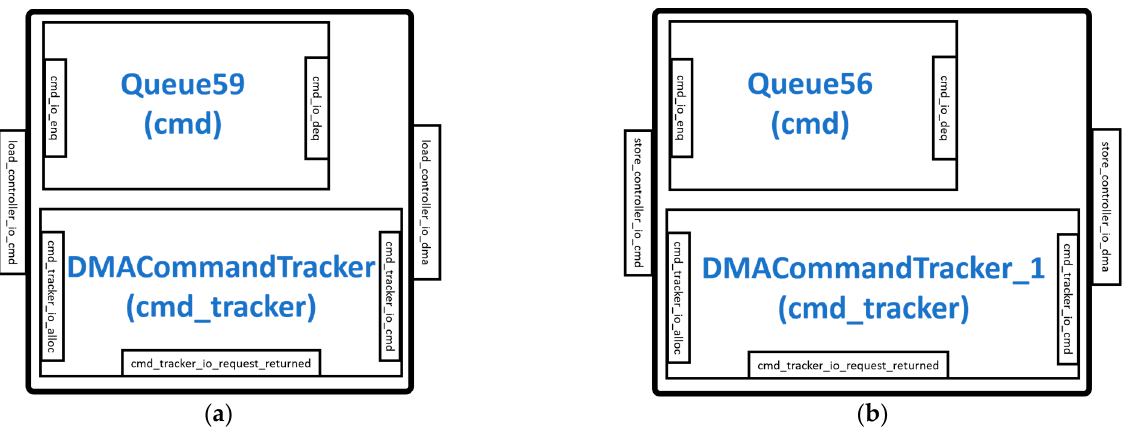
Figure 5. DMA controllers: ( a ) LoadController module; ( b ) StoreController